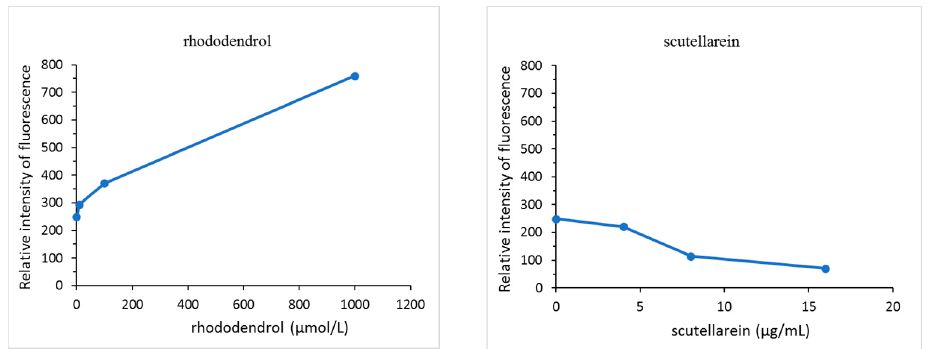
Figure 8. A comparison of free hydroxyl radical (˙OH) generation by the tested compound in the presence of tyrosinase.